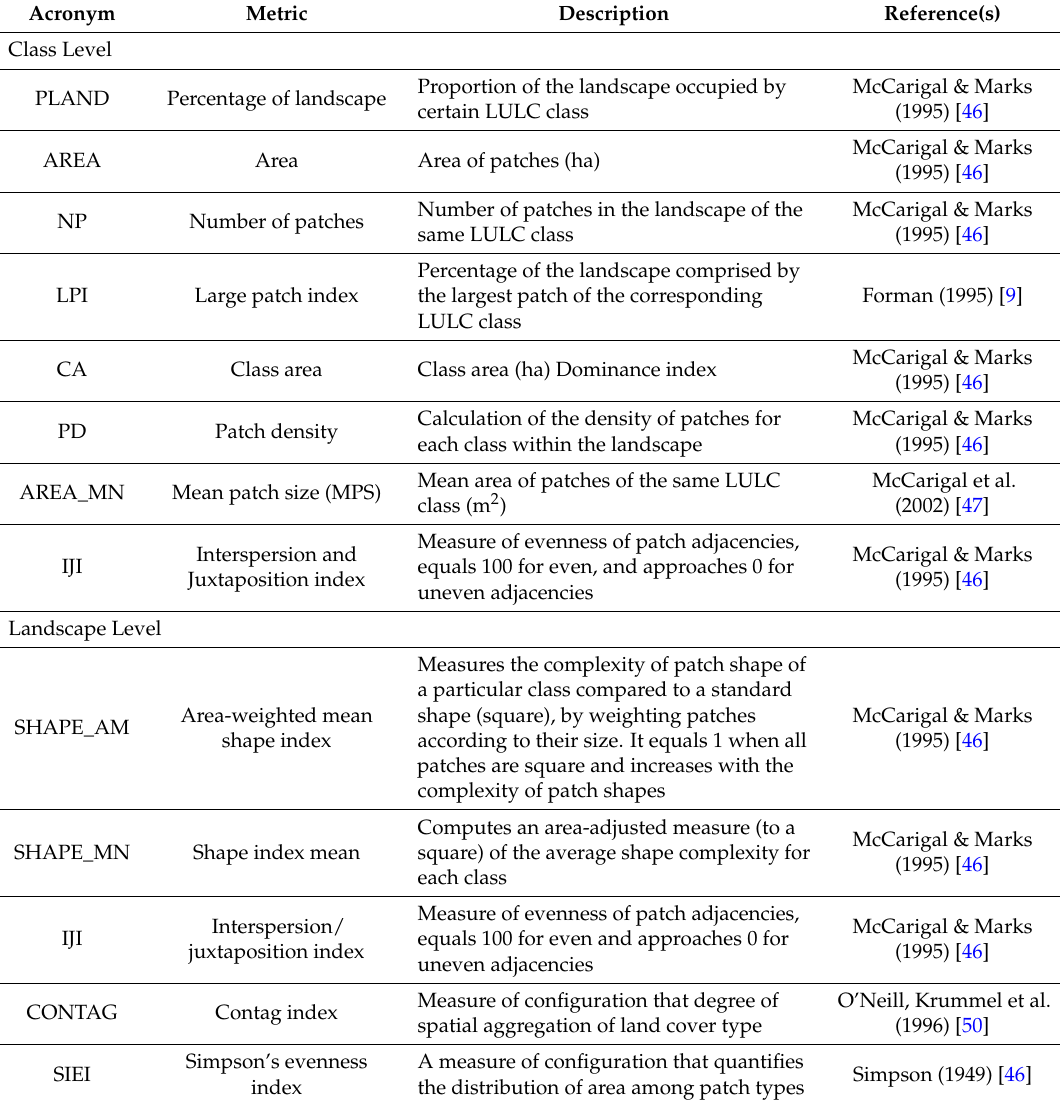
Table 2. Summary of landscape metrics used in this study (all formulas available